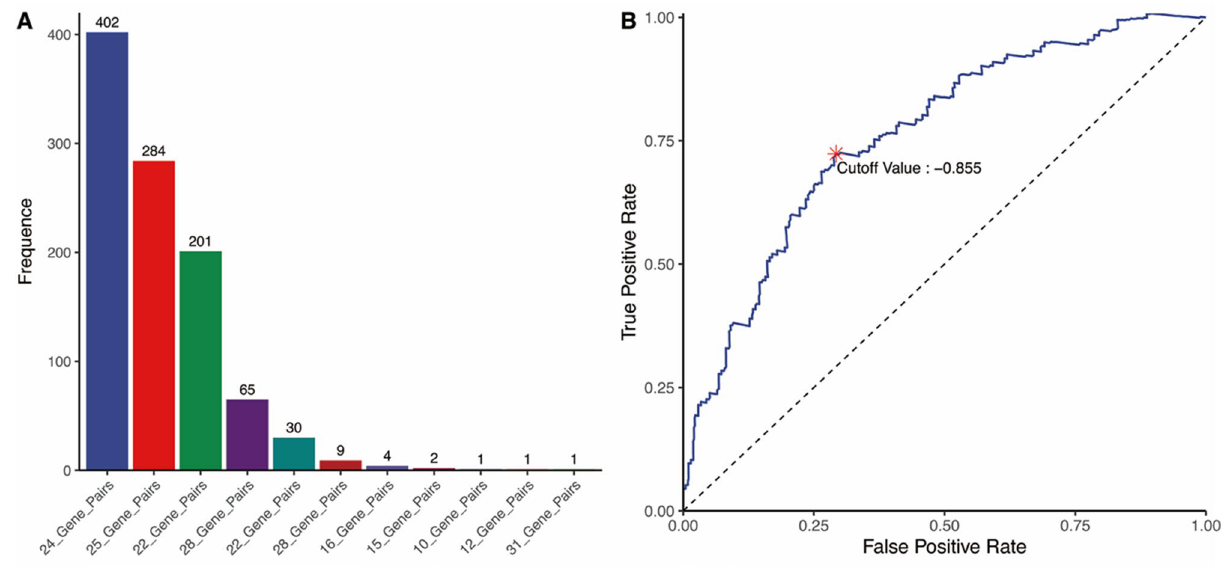
Figure 2. ( A ) The count of model of 1000 times Lasso Cox proportion hazards regression into training set. The 24 IRGPs with the highest frequency were selected for the development of IRGPI. ( B ) Time dependent receiver operating characteristic (ROC) curve within five years for IRGPI in the training cohort. The optimal IRGPI of − 0.855 was performed as cut off to divided patients into low- or high-IRGPI risk